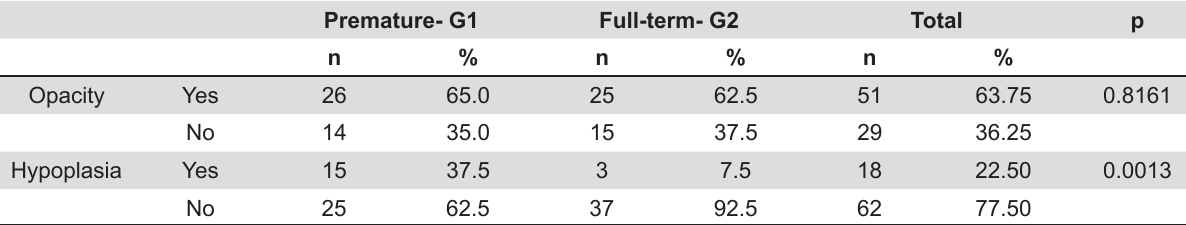
Table 1- Percentage of children in G1 and G2 who presented opacity and hypoplasia